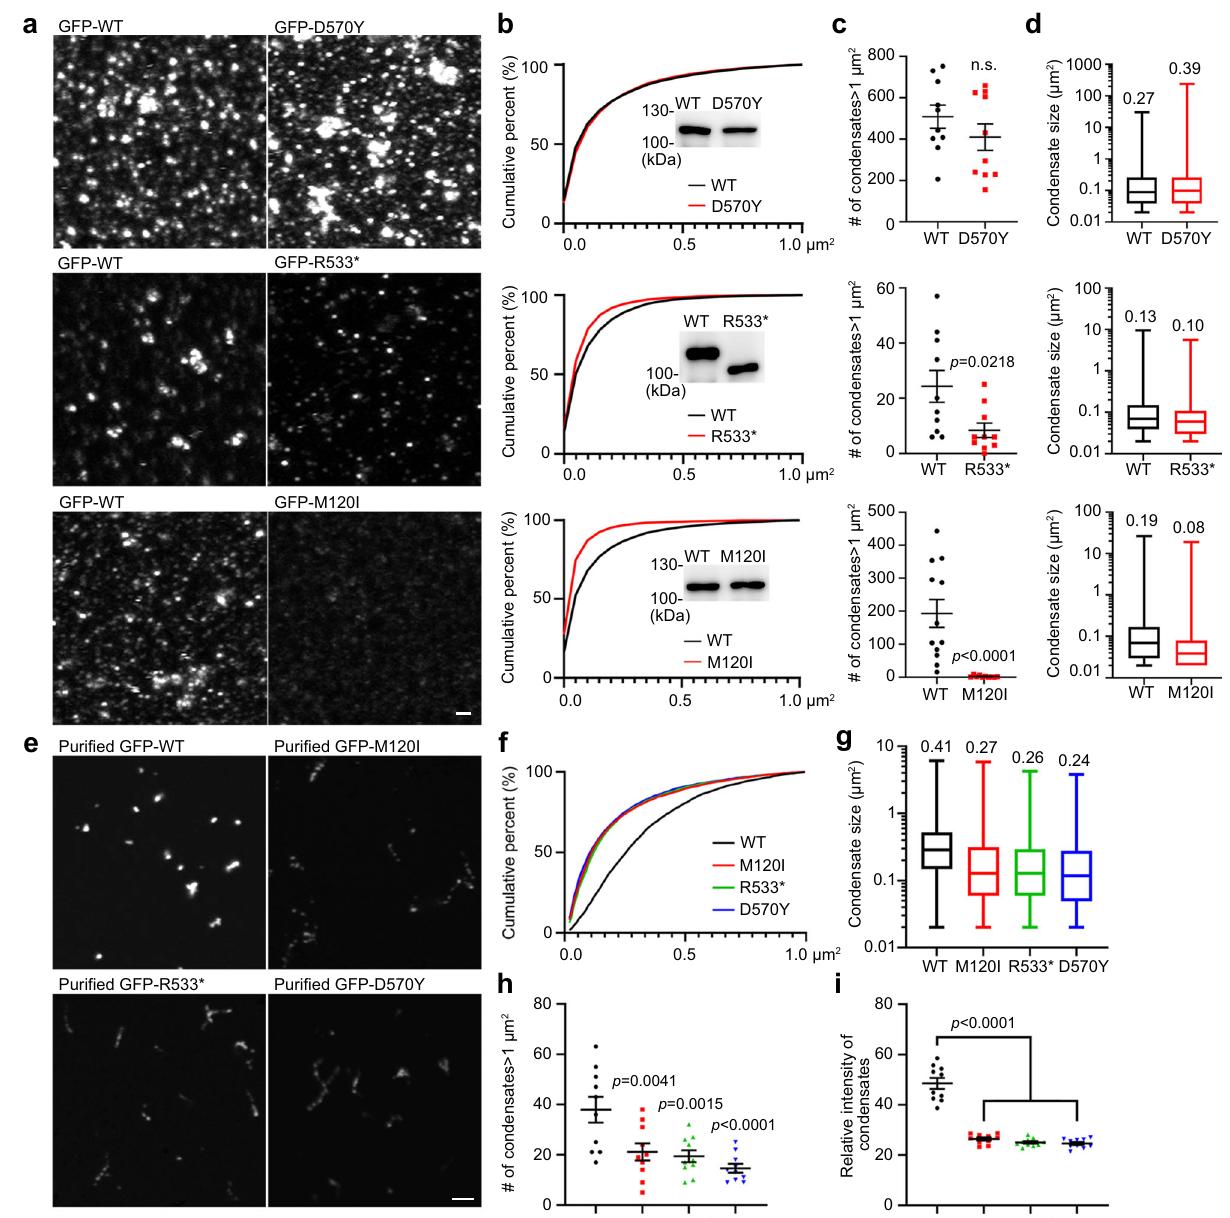
Fig. 4 ASD-linked CTTNBP2 mutations alter condensate formation. a Condensate formation by crude lysates of GFP-WT and ASD-linked mutant CTTNBP2. Images of condensates are shown. In different sets of experiments, protein levels varied due to differing cell densities and transfection ef fi ciencies. Condensate numbers of WT proteins may therefore vary in different sets of experiments. To con fi rm the expression levels of WT and mutant proteins were comparable in the same set of experiments, immunoblotting was performed (shown in b , actin loading controls are included in). WT CTTNBP2 was assessed in each set of experiments for comparison with mutant protein. b Cumulative probability of CTTNBP2 condensates <1 μ m 2 . Expression levels of the mutant and WT constructs were con fi rmed by immunoblotting, as indicated. c Numbers of CTTNBP2 condensates >1 μ m 2 . d Size of total CTTNBP2 condensates. Box-plots indicate median (middle line), 25th and 75th percentile (box), and min and max (whiskers). The indicated numbers are average sizes. N = 86801 (WT, top), 69450 (D570Y), 50488 (WT, middle), 26596 (R533*), 48929 (WT, bottom) and 7763 (M120I) condensates over 10 images collected from two independent experiments. e Condensate formation of puri fi ed GFP-WT and ASD-linked mutant CTTNBP2. Images of condensates are shown. f Cumulative probability of CTTNBP2 condensates <1 μ m 2 . g Condensate size of total CTTNBP2 condensates. Box-plots indicate median (middle line), 25th and 75th percentile (box), and min and max (whiskers). The indicated numbers are average sizes. N = 4595 (WT), 4156 (M120I), 4074 (R533*) and 4088 (D570Y) condensates over 10 images collected from two independent experiments. h Numbers of